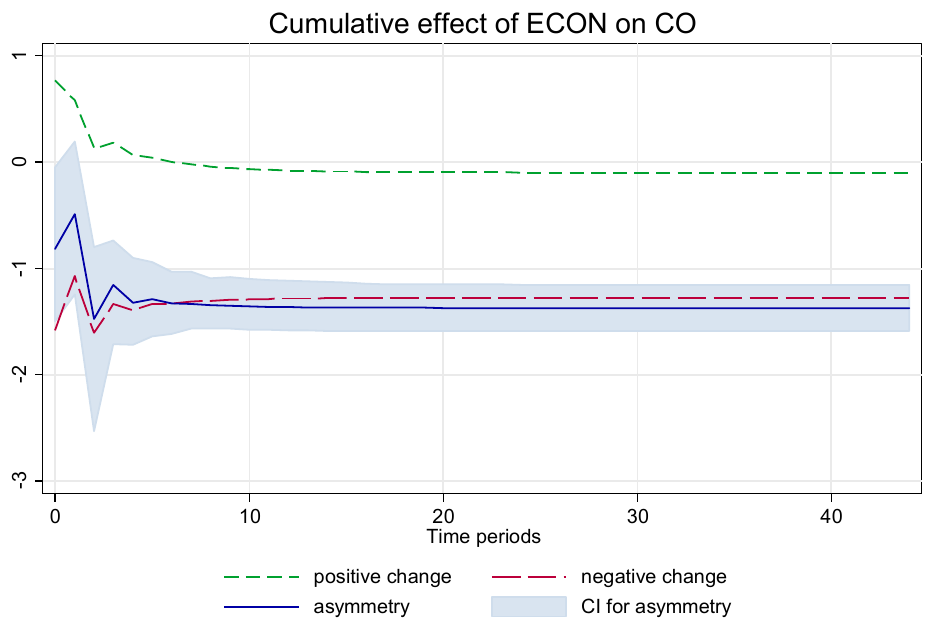
Figure A9. Cumulative effect of ECON on CO.